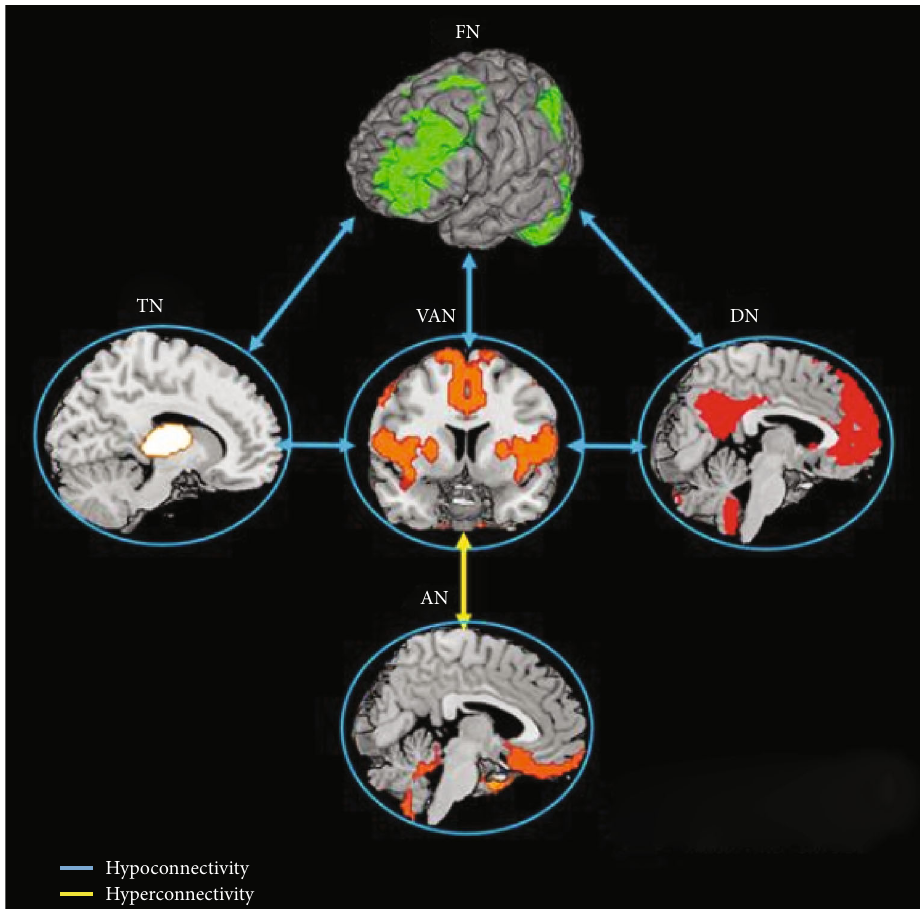
Figure 3: The salience network. Reduced connectivity within the salience monitoring systems (ventral attention network (VAN), thalamus network (TN)) and imbalanced connectivity among the salience systems and networks involved in internal thought (default network (DN)) and external goal-direction regulation (frontoparietal network (FN)) may re fl ect a weakness in salience processing that contributes to the general de fi cits in both external goal-directed behavior and self-awareness. Meanwhile, reduced connectivity between the FN and TN, which are involved in gathering information, may underlie the loss of salient information management control. Furthermore, decreased connectivity within neural systems involved in emotion processing and hyperconnectivity between the emotion system (AN) and the salience processing system (VAN) may relate to the de fi cits in emotion perception and regulation. Circles refer to reduced connectivity within the corresponding networks